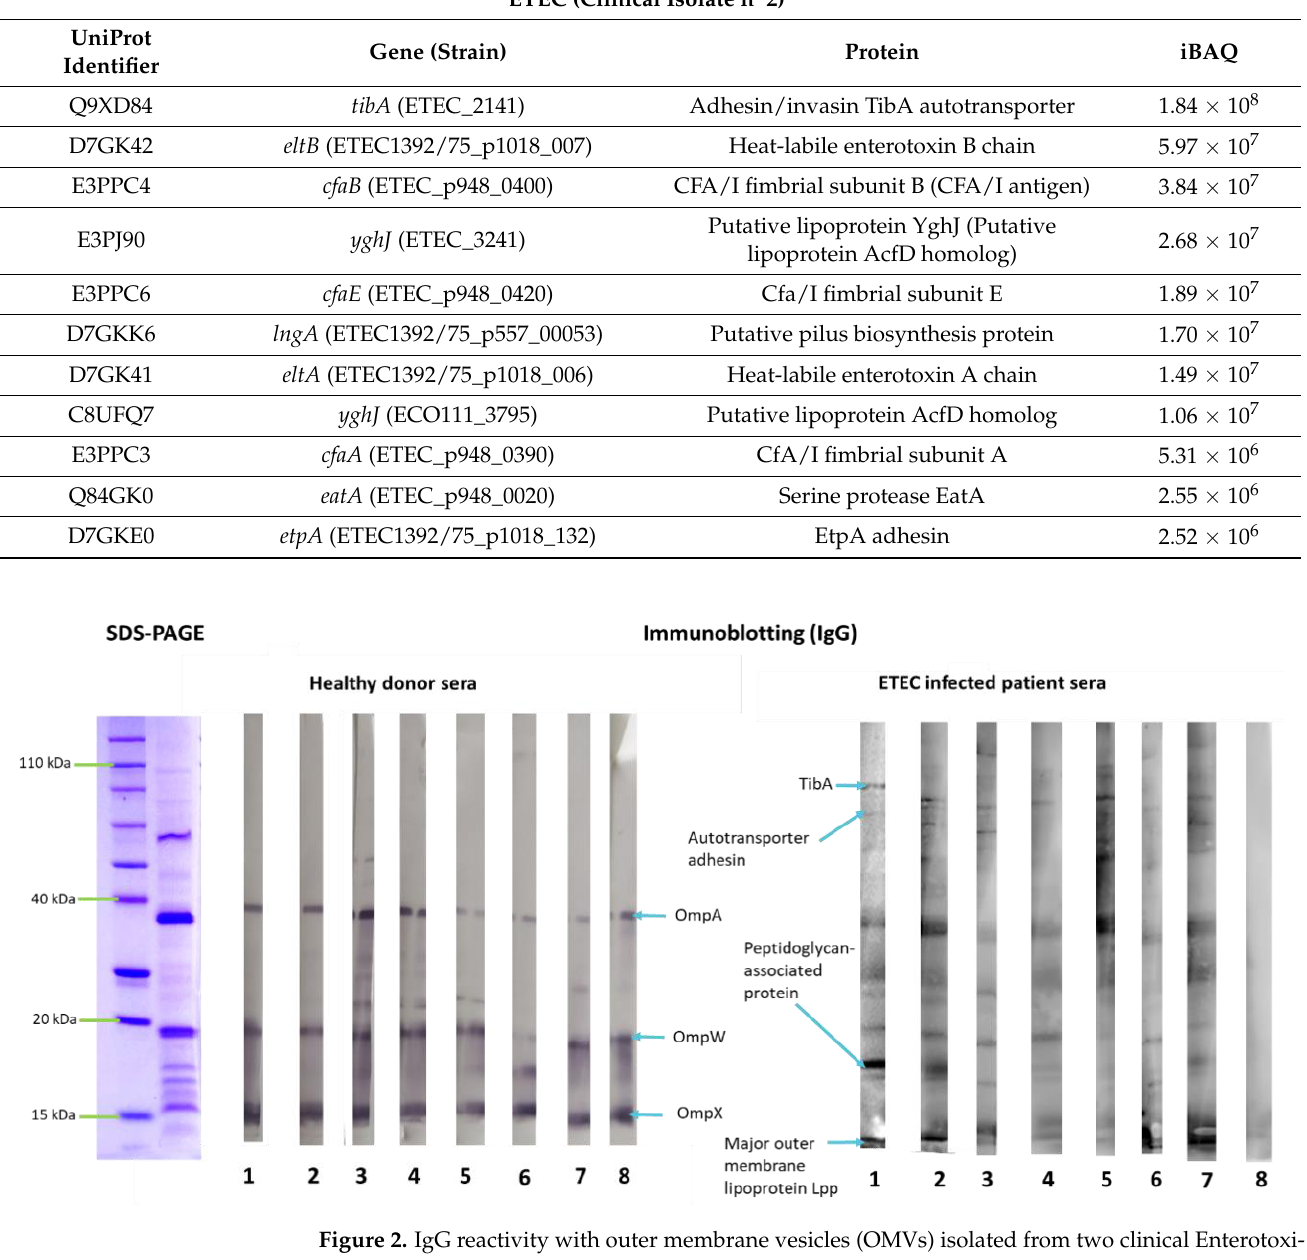
Table 2. Enterotoxigenic Escherichia coli (ETEC) virulence factors identified in outer membrane vesicles (OMV) isolated from the ETEC clinical isolate nº2. Protein quantification is expressed in iBAQ. ETEC (Clinical Isolate n ◦ 2)